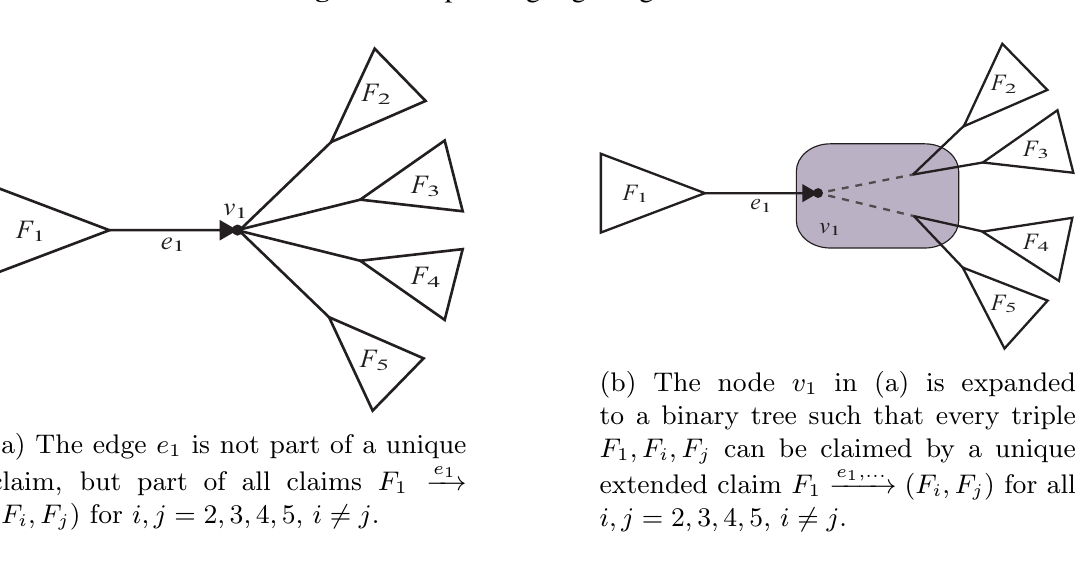
Figure 9. Expanding high-degree